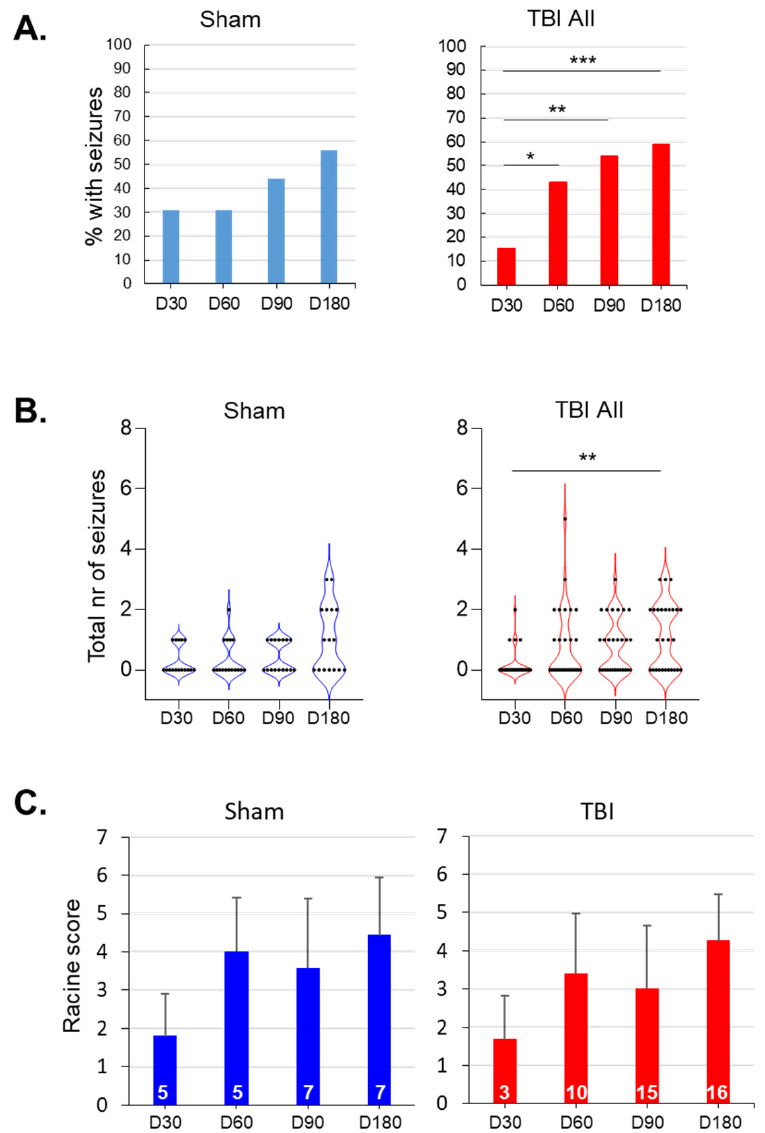
Figure 7. Evolution of seizure susceptibility over the 7-month follow-up: ( A ) Bar graphs showing the percentage of rats ( y -axis) with pentylenetetrazol (PTZ)-induced seizures on day (D) 30, D60, D90, and D180 after sham operation ( n = 16) or traumatic brain injury (TBI; n = 28). In the TBI group, the percentage of rats with seizures increased over time (adjusted *** p < 0.001, ** p < 0.01, * p < 0.05 compared with that at D30; related-samples Cochran’s Q test). ( B ) Violin plots showing the total number of PTZ-induced seizures ( y -axis) in each animal during different testing sessions. Each black dot represents 1 animal. The general linear model revealed a significant effect of time on the seizure count ( p < 0.001), but no group or time x group effects ( p > 0.05). Although the seizure number increased in both the sham-operated and TBI animals, the only significant difference detected was in the TBI group when the D30 and D180 timepoints were compared (adjusted ** p < 0.01; related-samples Friedman’s 2-way ANOVA). ( C ) Average Racine score ( ± standard deviation) of the first PTZ-induced seizure on each testing day ( y -axis). The general linear model revealed a significant effect of time on the seizure count ( p < 0.001), but no group or time x group effects (both p > 0.05). In the TBI group, the Racine score tended to increase over time (related-samples Friedman’s 2-way ANOVA, p < 0.05), but pairwise comparisons did not survive Bonferroni corrections for multiple testing (adjusted p > 0.05). The numbers within each bar indicate the number of rats with seizures on that testing